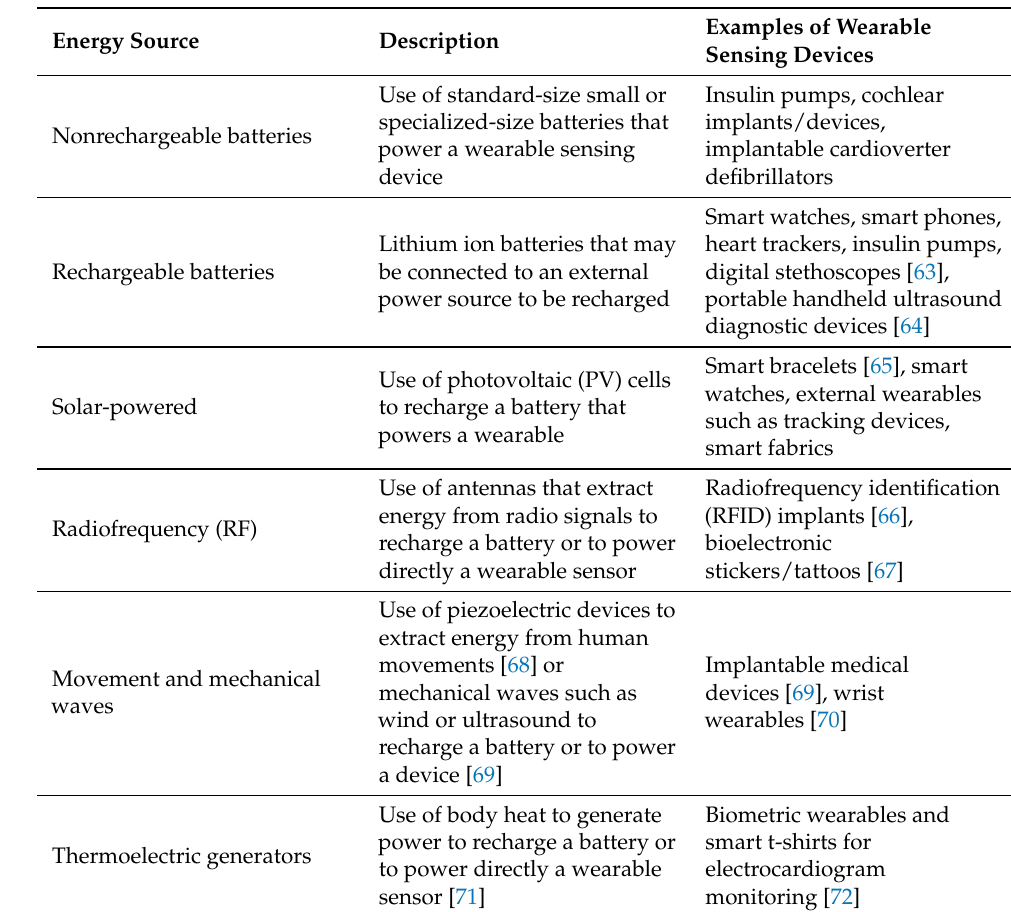
Table 2. Energy sources for wearable sensing devices.